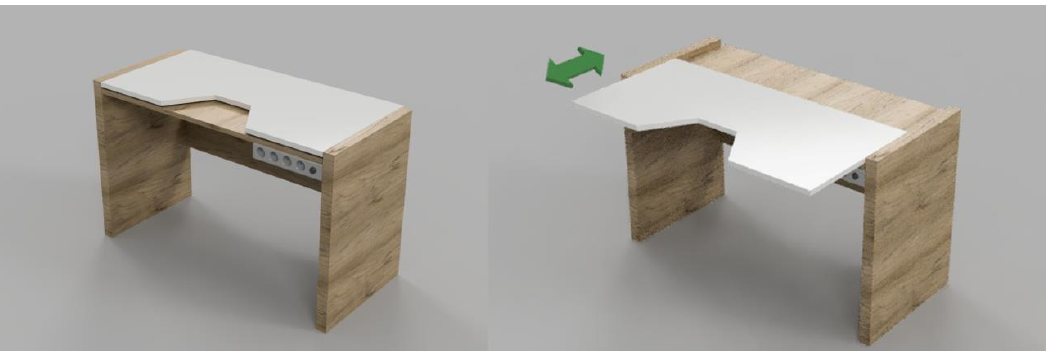
Figure 5. Design of a desk for an investor with muscle atrophy (picture: Students participating in the 8th edition of JAI).